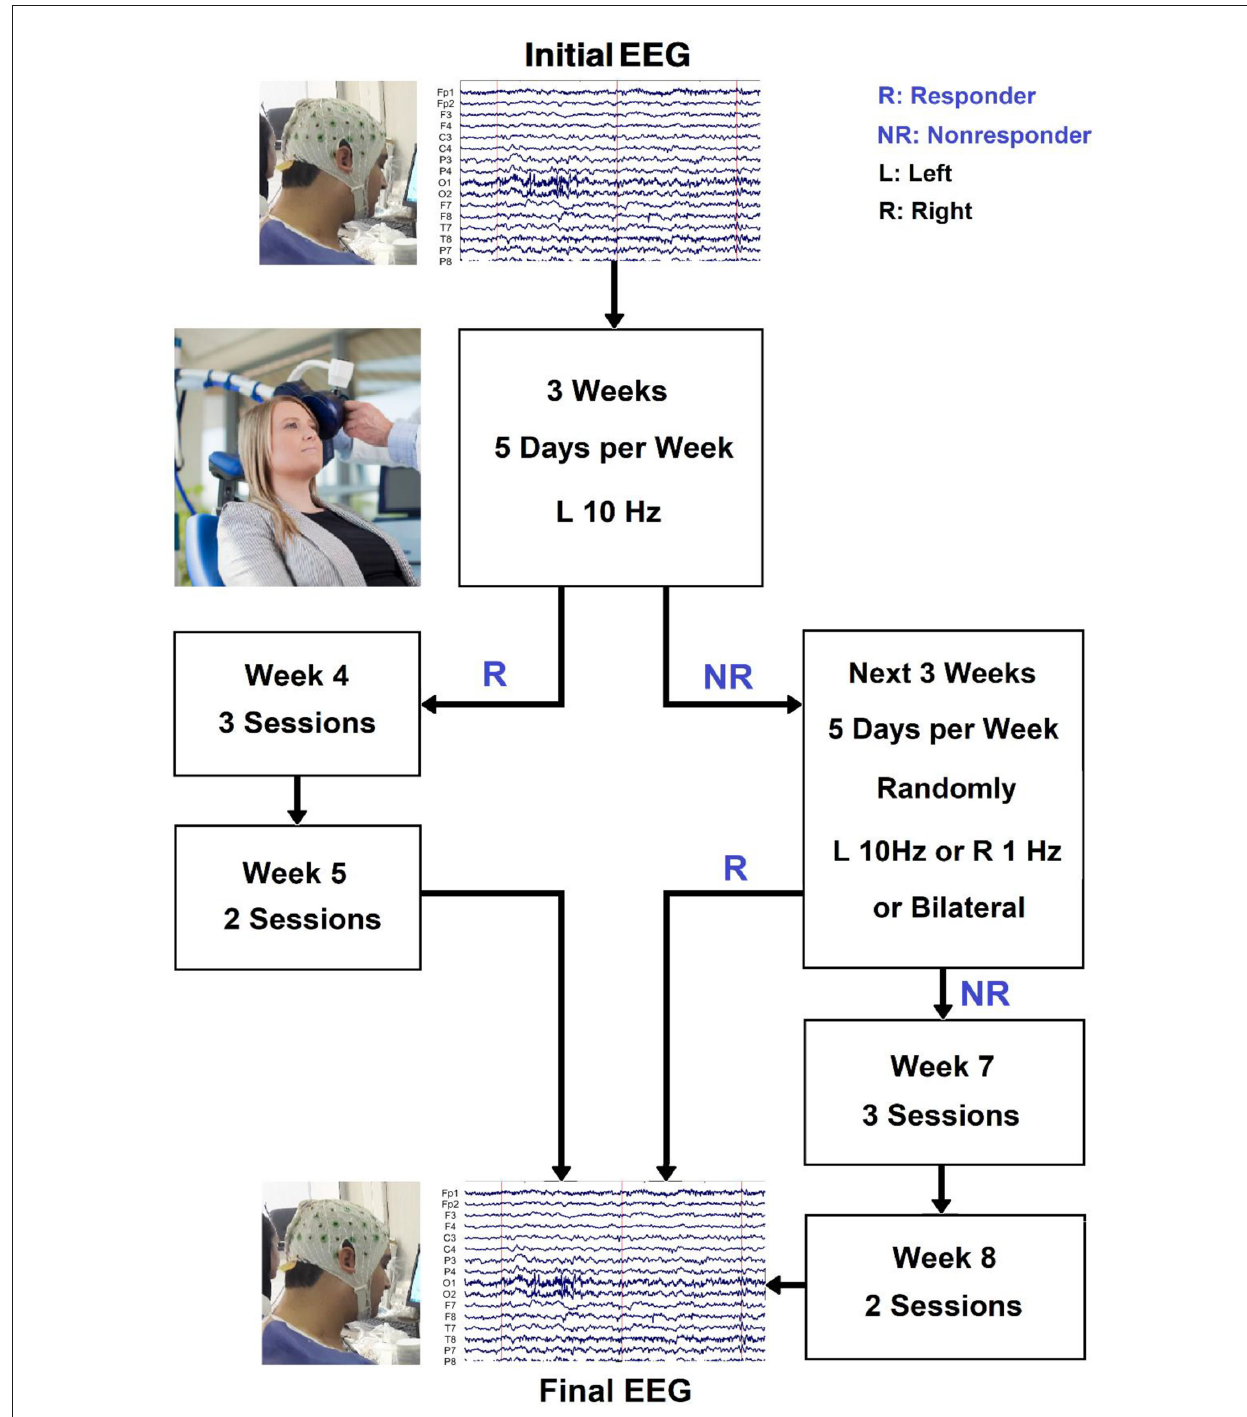
FIGURE2 The procedure for rTMS treatment and the selection of two responsive (R) and nonresponsive (NR) groups.